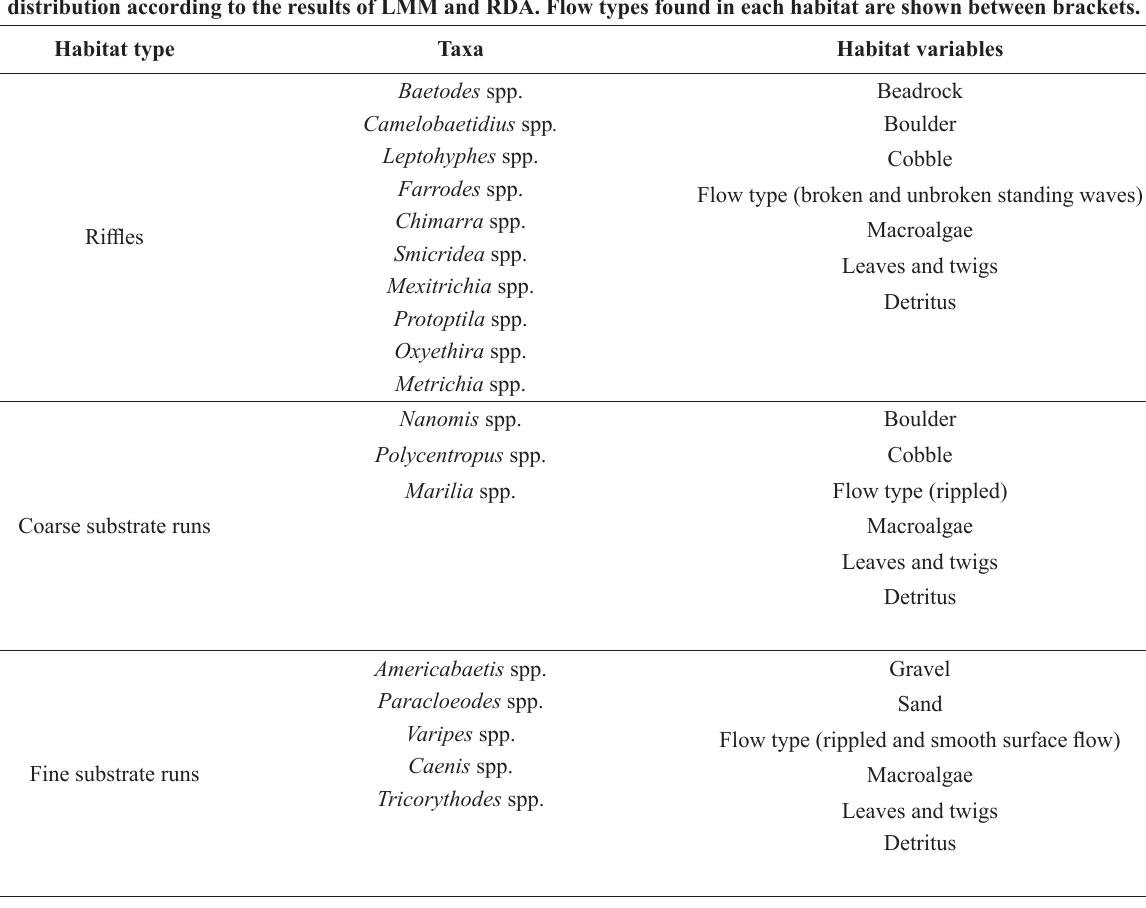
Ephemeroptera and Trichoptera taxa associated to each habitat and the most important variables conditioning taxa distribution according to the results of LMM and RDA. Flow types found in each habitat are shown between